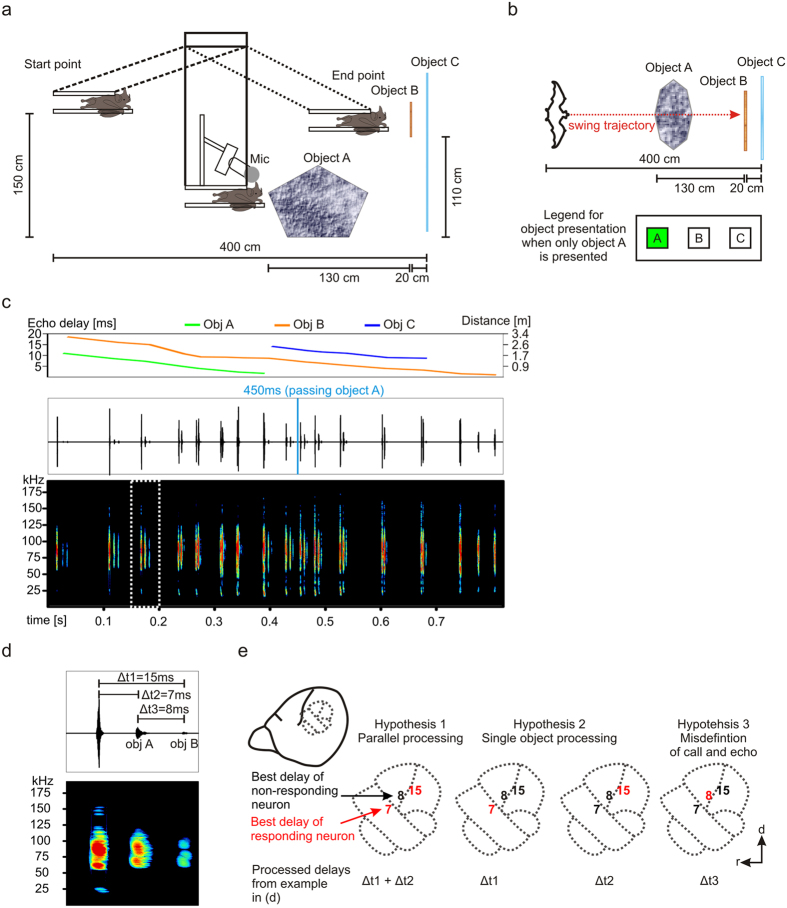
Natural echolocation sequence consisting echo information from three objects.(a) Schematic side view (not in scale) of the pendulum paradigm. The animal was fixed in a pendulum and it was swung towards three objects. During the swing the animal echolocates. Biosonar calls and echoes were recorded with an ultrasonic microphone (Mic) that was positioned above the animal’s head and it was pointing into the direction of the swing. The distance between the microphone and the animal’s ears was about 4 cm. During the swing object A, mimicking the shape of a rock was overflown by the bat. Object B was a wooden plate and object C was an acrylic glass wall. (b) Top: Schematic top view (not in scale) of the recording set up. Bottom: Example of a legend indicating a “single-object sequence” in which object A (green filled rectangle) is represented in the echolocation sequence, while echoes from object B and object C (unfilled rectangles) are absent. (c) Top: Change of object specific “echo-delays” along the time axis of the sequence. Each object is represented by a differently colored line. Bottom: Oscillogram and spectrogram of the echolocation sequence that was used as acoustic stimulus for electrophysiological recordings. The blue vertical line at 450 ms indicates the time point of passing object A. (d) Magnification of one call-echo element marked by white dashed rectangle in (c). The echo-delays are indicated in the oscillogram. (e) Three hypotheses (1–3) regarding how the echo-delays of the call-echo element in (d) could be processed in the cortex of C. perspicillata. Schematic lateral view on C. perspicillata’s brain and magnified auditory cortical areas (dashed lines). Numbers in the cortical areas represent the best delay to which the neurons respond to. Red numbers indicate responding and black numbers non-responding neurons when the animal is stimulated with the call-echo element based on the corresponding hypothesis. Note that according to hypothesis 3 the delay between two consecutive echoes (Δt3 in d) is processed and not the echo-delay between call and echo (Δt1 or Δt2 in d). d = dorsal; r = rostral.